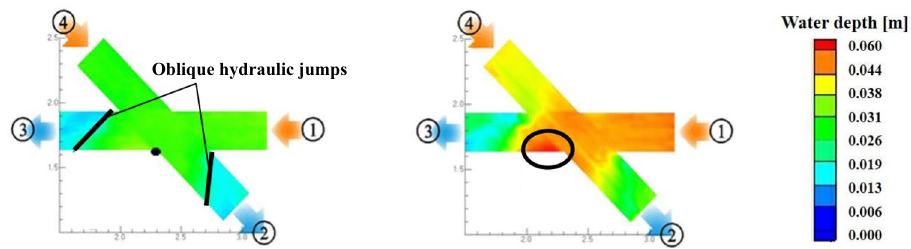
Fig. 8 Spatial variation of water depth around the confluence: Case